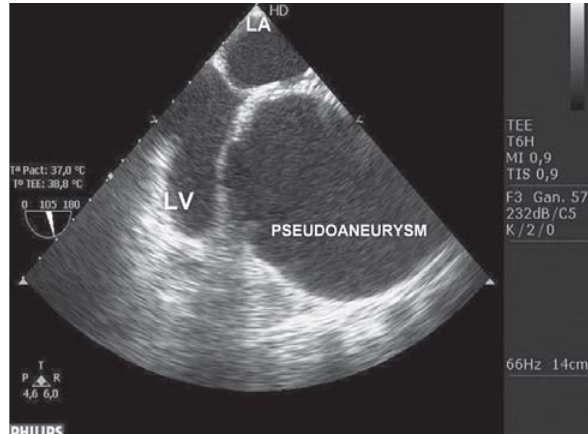
Fig. 3 - Multi-slice chest CT showing an enlarged ascending aorta (8 cm antero-posterior diameter) close contact to the retrosternal